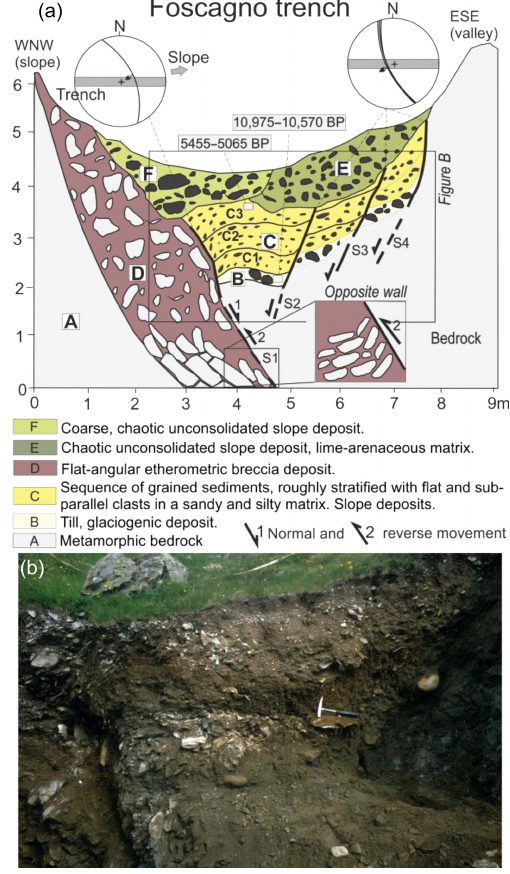
Figure 5. (a) Log of the southern trench wall excavated across the lower DSGSD structure near the Foscagno Pass (central Alps, Italy; see Fig. 4 for location). Inset shows a log of the southern trench wall where the dragging of layers and clasts along the slip plane S1 is consistent with reverse movements. Plane S1 was previously an extensional fracture. Stereograms (Schmidt’s projection, lower hemisphere) show the geometry of slip planes and orientation of the trench. (b) Photo of the trench wall included in the box of Fig.